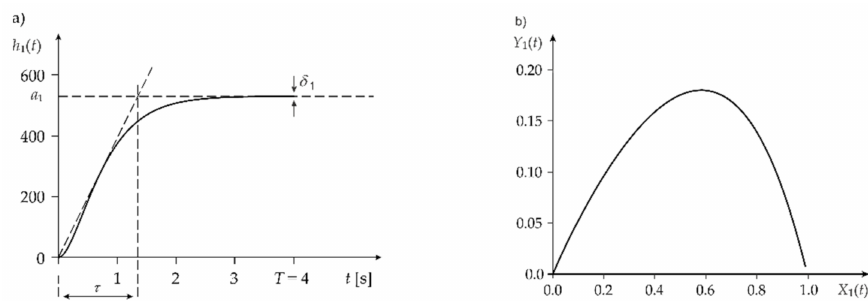
Figure 5. Example characteristics for the SCA machine: ( a ) step response; ( b )